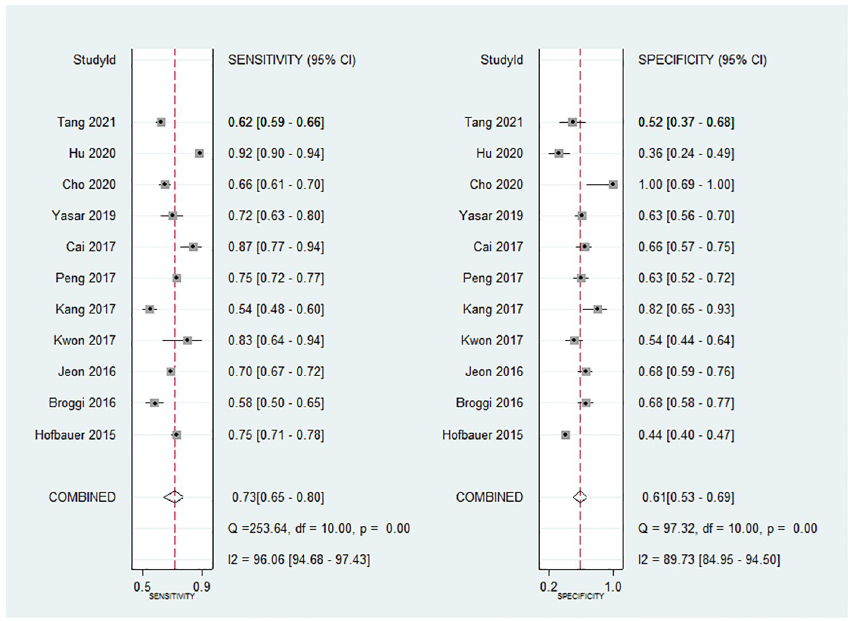
Fig 3. Forrest plot of the sensitivity and specificity of the prognostic nutritional index as prognostic value for renal cell carcinoma. CI indicates confidence interval.